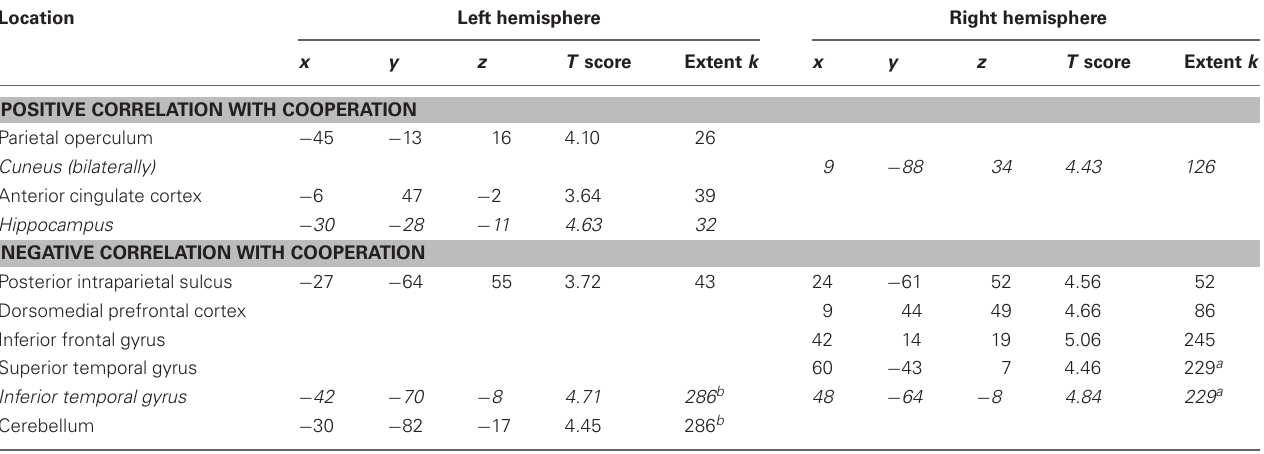
Table 2 | Brain areas in which activity correlates with levels of cooperation ( p < 0 . 001 uncorrected, extent k > 25).